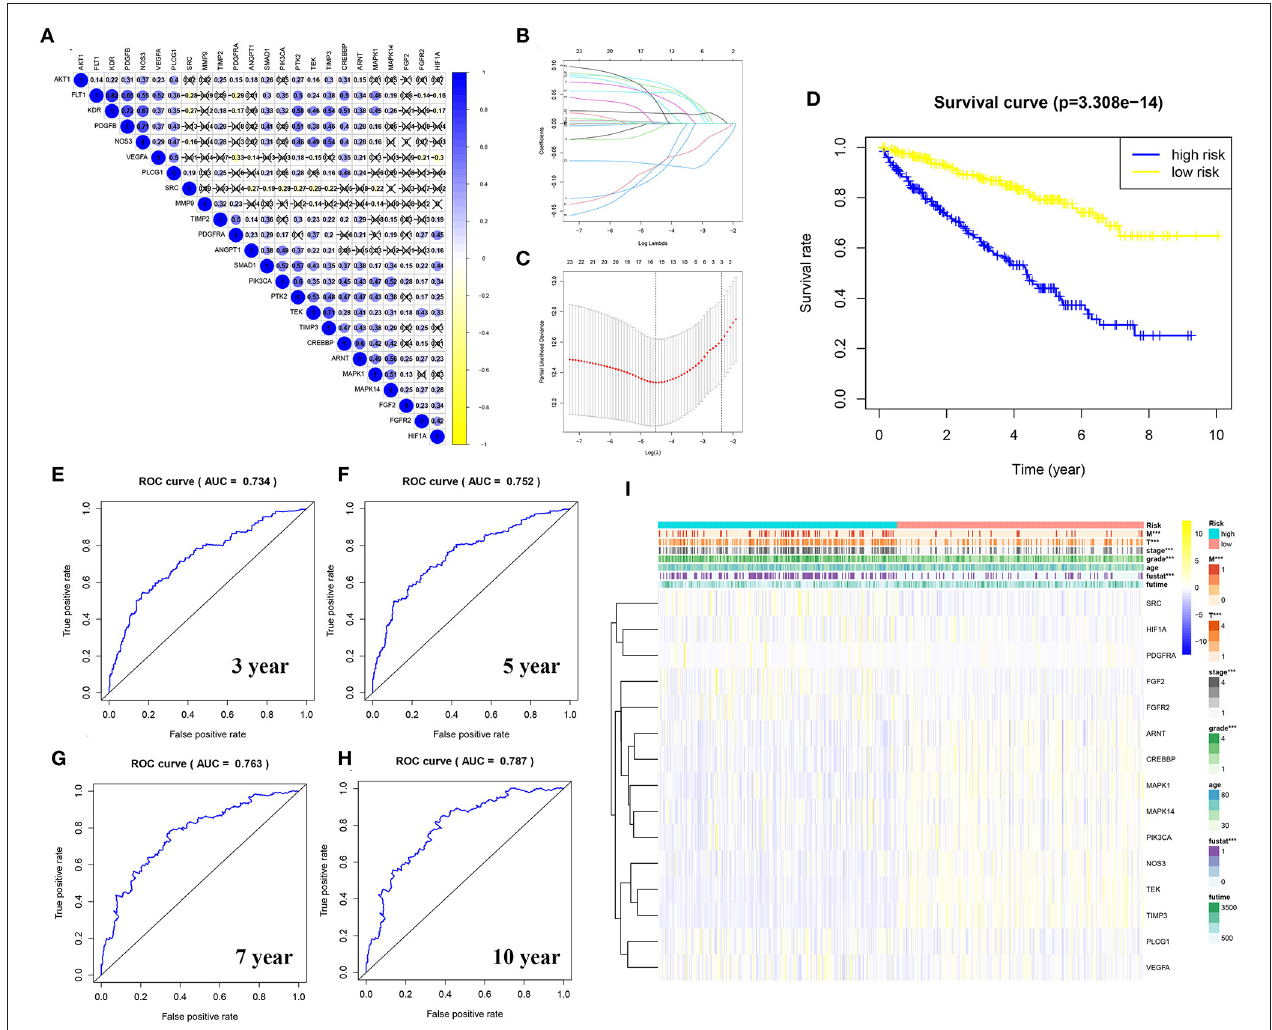
FIGURE 7 | Construction of a risk model using the least absolute shrinkage and selection operator (LASSO)–Cox regression analysis. (A) The plot shows the result of co-expression relationships of 24 angiogenesis pathway genes in KIRC. In the color bar on the right side, blue represents positive correlation and yellow represents negative correlation. (B) The LASSO coefficient profiles of angiogenesis pathway genes in KIRC. (C) The distribution and median value of the risk scores. Fifteen genes were screened by LASSO Cox regression analysis. (D) The survival curve was obtained based on this model. The overall survival rates of patients in the high-risk group were significantly lower than those of the patients in the low-risk group. Blue represents the high-risk group and yellow represent the low-risk group. (E–H) ROC curve of 3-, 5-, 7-, and 10-years, area under the curve (AUC) of the curve are 0.734, 0.752, 0.763, and 0.787, respectively. (I) The correlation of risk score and the clinicopathological characteristics. The color bar shows the expression of genes. Yellow represents the upregulation of genes, blue represents the downregulation of genes (*** p <